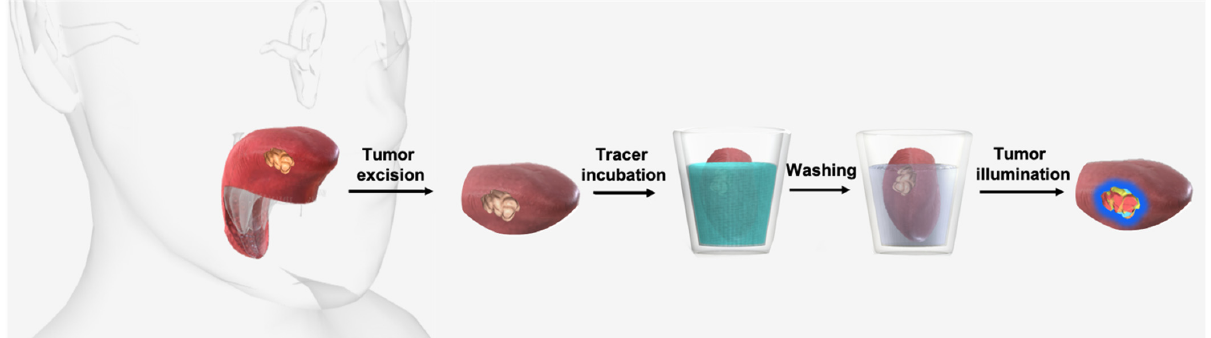
Figure 1. Tumor incubation and illumination. Schematic overview of the workflow from tumor excision to illumination. After excision, the tongue tumor sample was incubated in a solution containing EMI-137. After washing to eliminate unbound tracer, fluorescence imaging allowed visualization of the tumor within the specimen.